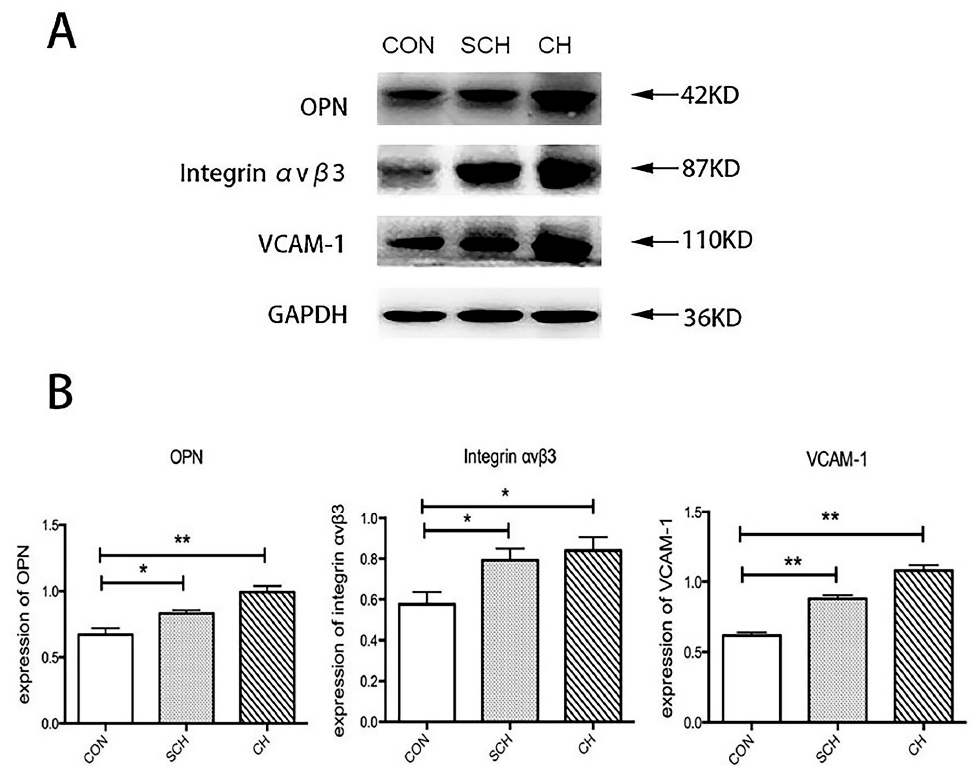
Figure 1. Osteopontin (OPN), integrin α v β 3 , and vascular cell adhesion molecule (VCAM-1) expression in aorta; tissues of control (CON), subclinical hypothyroidism (SCH), and hyoithyroidism (CH) rats. ( A ) The bands depict representative findings regarding protein expression levels of OPN, integrin α v β 3 , and VCAM-1 protein expression in the aortic tissues in CON, SCH, and CH rats. These were evaluated by Western blotting using protein extracted from 20 mg of aorta tissues; ( B ) The bar graph shows the results of the semiquantitative measurements of OPN, integrin α v β 3 , and VCAM-1. Values are shown as the means ± SEM. * p < 0.05 versus CON group; ** p < 0.01 versus CON group.